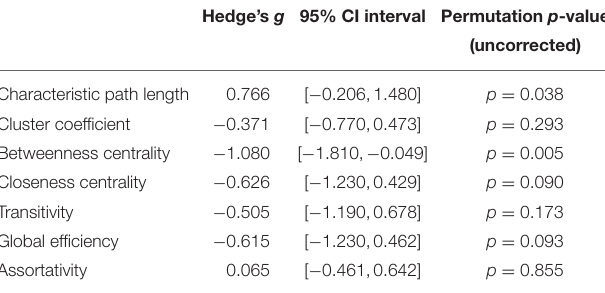
TABLE 3 | Permutation test statistics for the SCZaff group (sample size n =